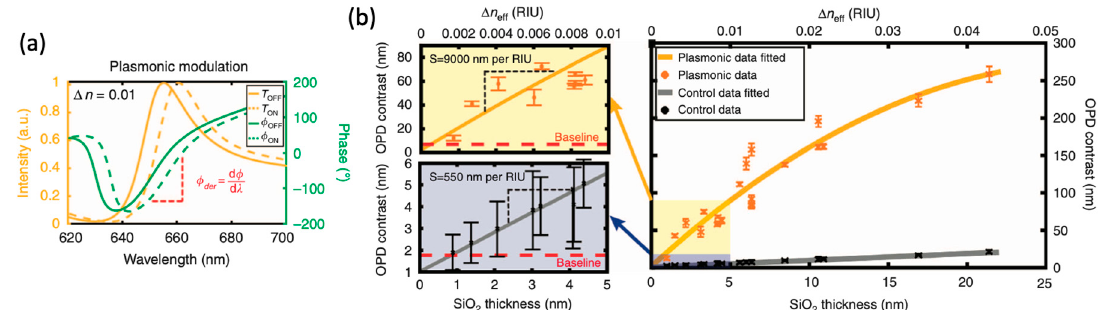
Figure 9. ( a ) Intensity (yellow color) and phase (green color) profiles for 0.01 RIU change. ( b ) OPD contrast comparison between this plasmonic sensor (orange color) and a transparent substrate (grey color) for different thickness of SiO 2 cover layer. Zoomed in range for thin SiO 2 is plotted separately for this plasmonic sensor (left top plot) and a transparent substrate (left bottom plot). Adapted from [104], with permission © 2018 Springer Nature Publishing AG.